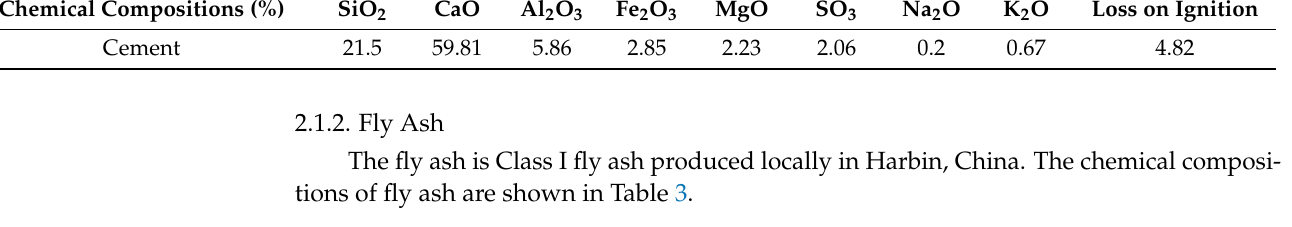
Table 3. Chemical compositions of fly ash.